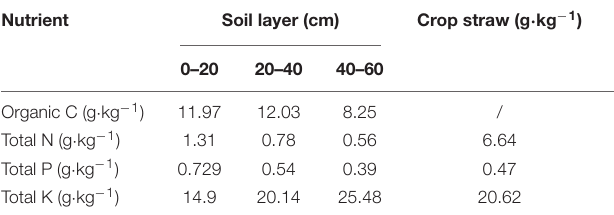
TABLE 1 | Nutrient contents of incorporated wheat straw and soil nutrient contents in different soil layers before planting (g · kg − 1 ).